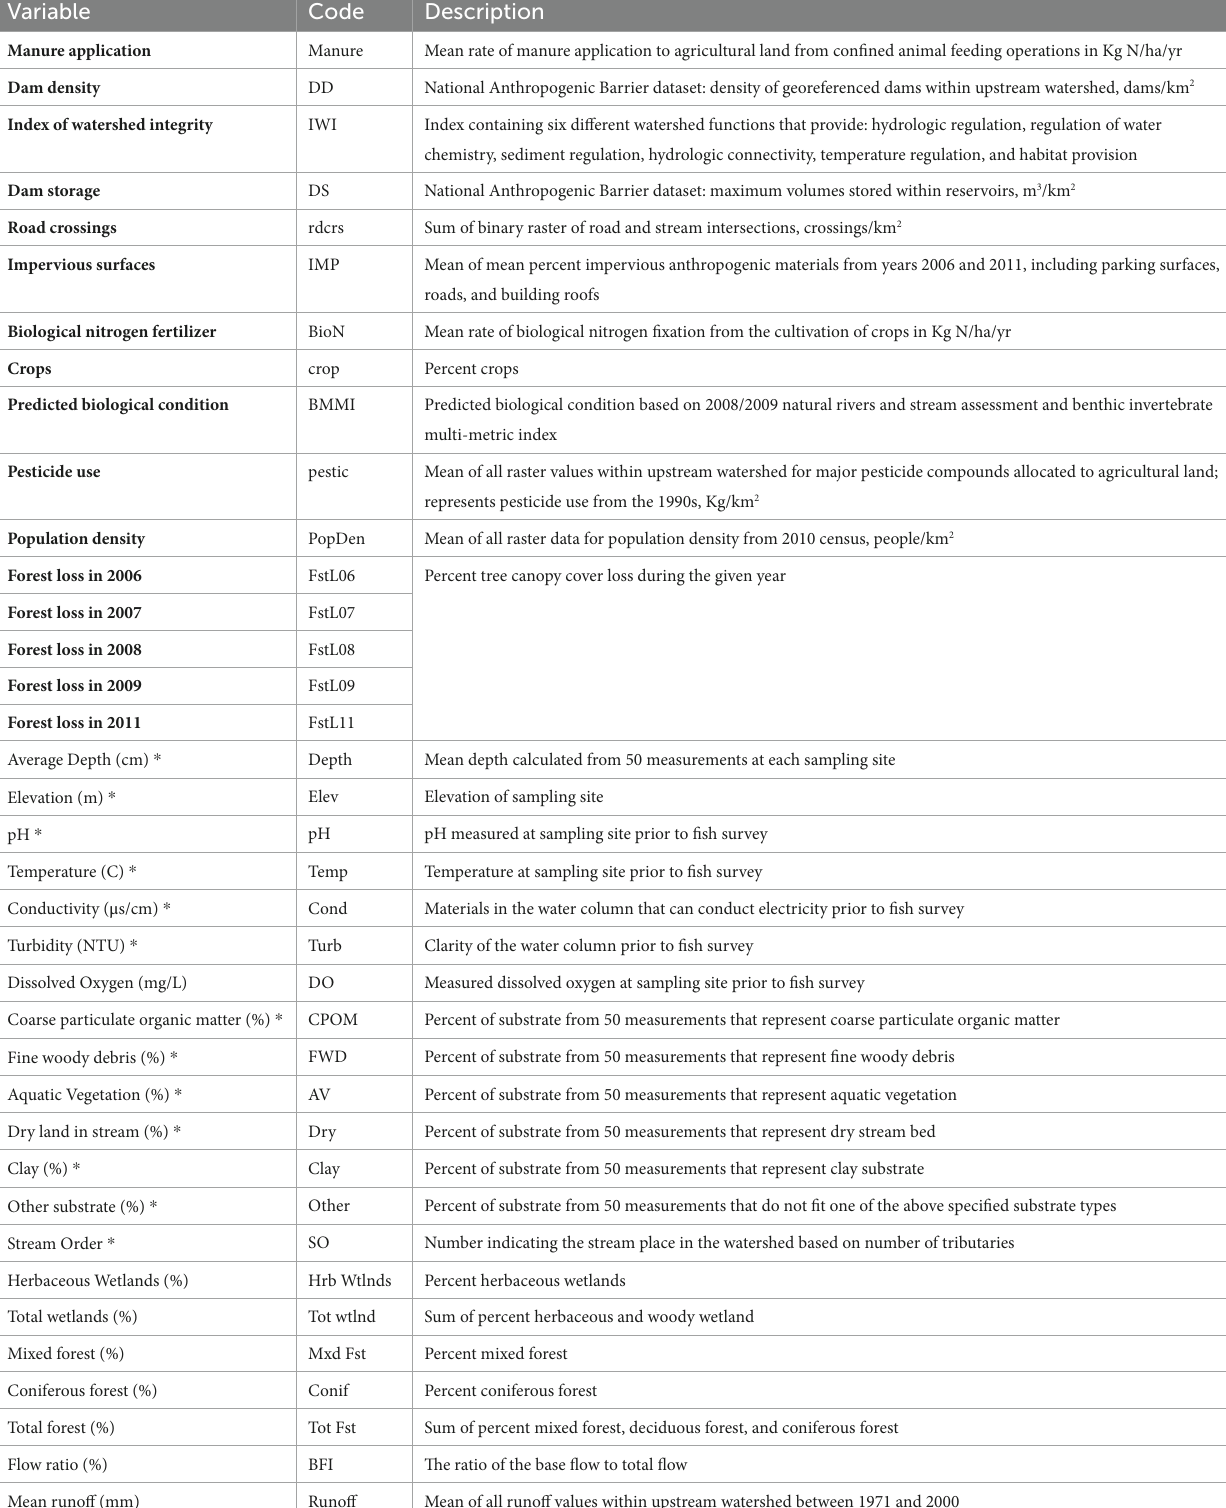
TABLE 2 Descriptions and codes for selected variables used in analyses of stream fish abundance.